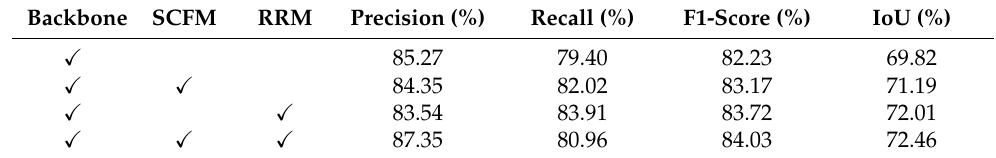
Table 4. Quantitative evaluation of the combination of different modules on the Guangzhou data set. Backbone